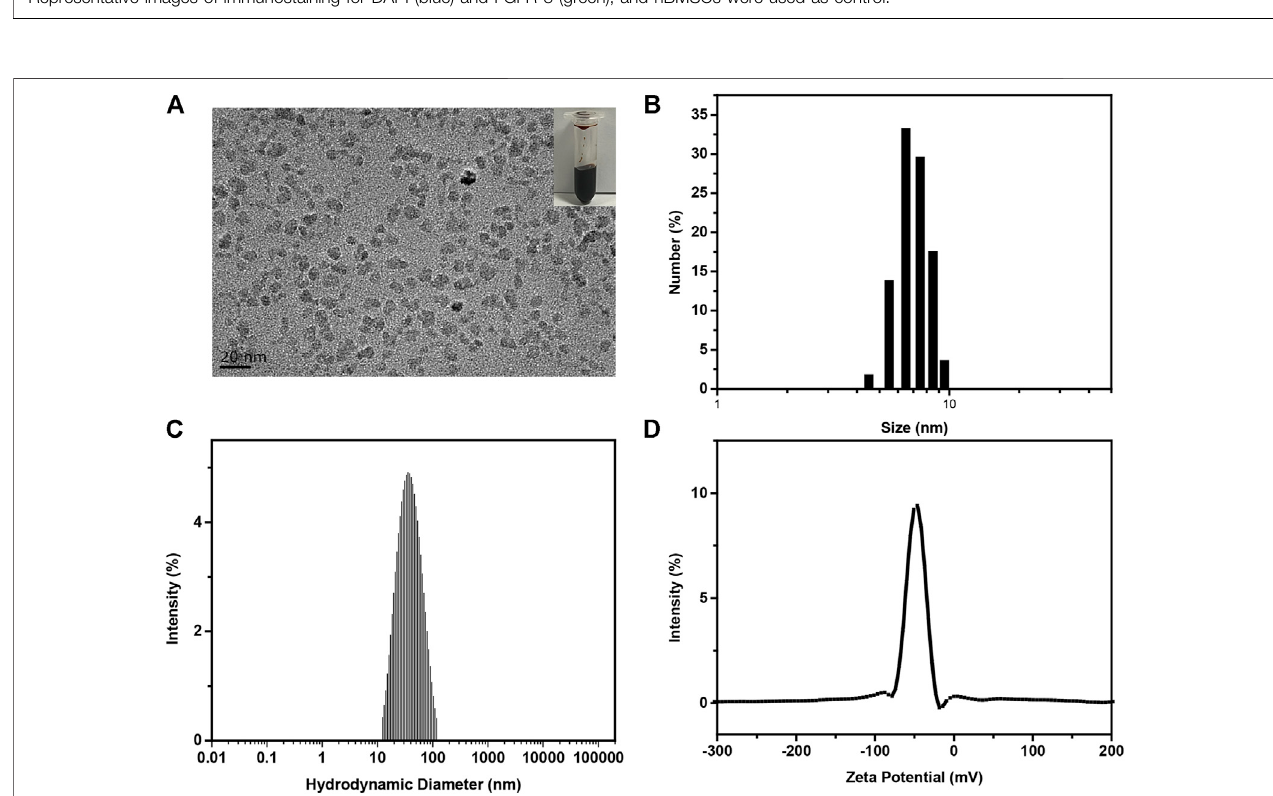
FIGURE2| Preparation and characterizationofIONPs. (A) TypicalTEM image, (B) statistical sizedistributionaccording to (A – C) hydrodynamic diameter, (D) zeta potential of as-prepared PSC-coated IONPs.